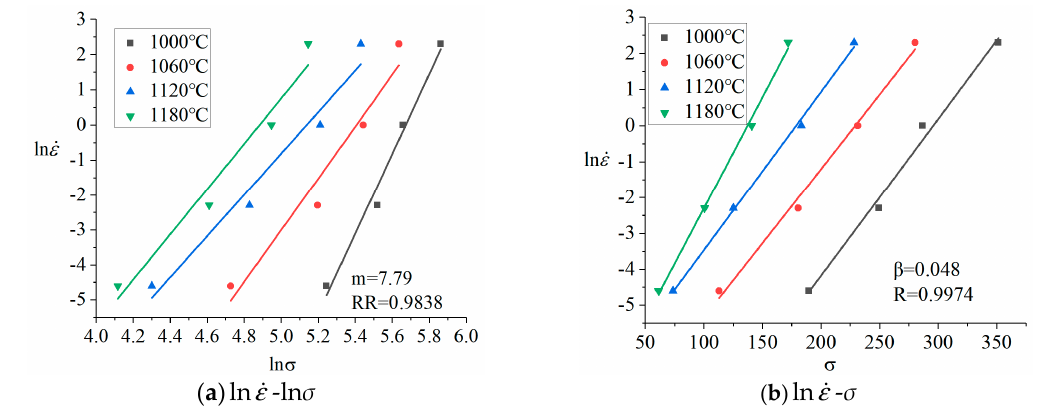
. . ε and ln σ ; ( b ) ln ε and σ .